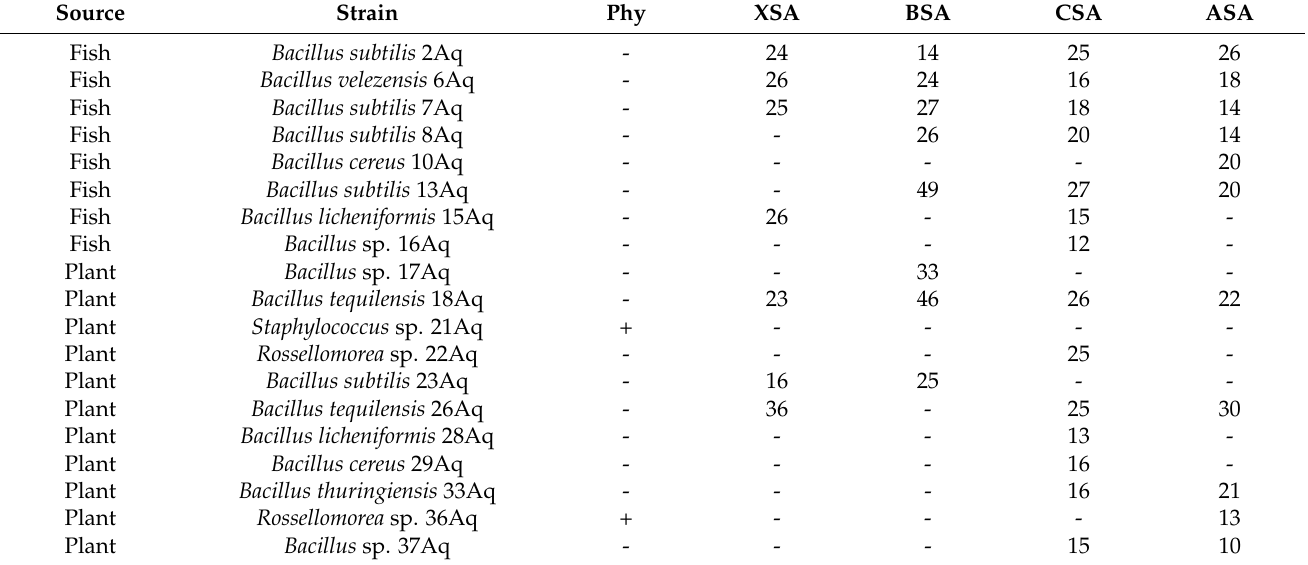
Table 5. Bacterial isolates from the fish and plant compartments of the aquaponics system with the ability to produce extracellular phytase (increase extracellular phosphate concentration in PSM medium), xylanase (XSA, xylanase screening agar clear zone in mm), β -glucanase (BSA, β -glucanase screening agar clear zone in mm), cellulase (CSA, cellulase screening agar clear zone in mm), and amylase (ASA, amylase screening agar clear zone in mm). ‘+’ indicates significant extracellular enzyme activity and ‘-’ no extracellular enzyme activity was